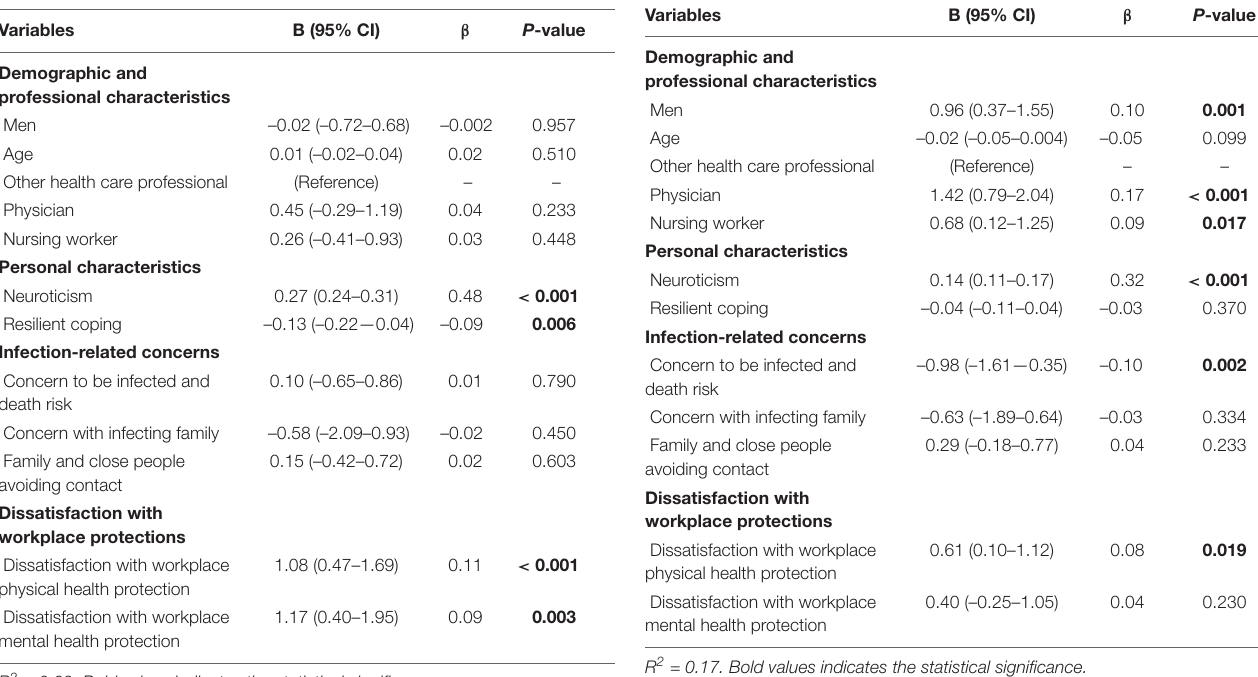
TABLE 4 | Multivariable model of depersonalization indicators among Brazilian frontline health care workers during the COVID-19